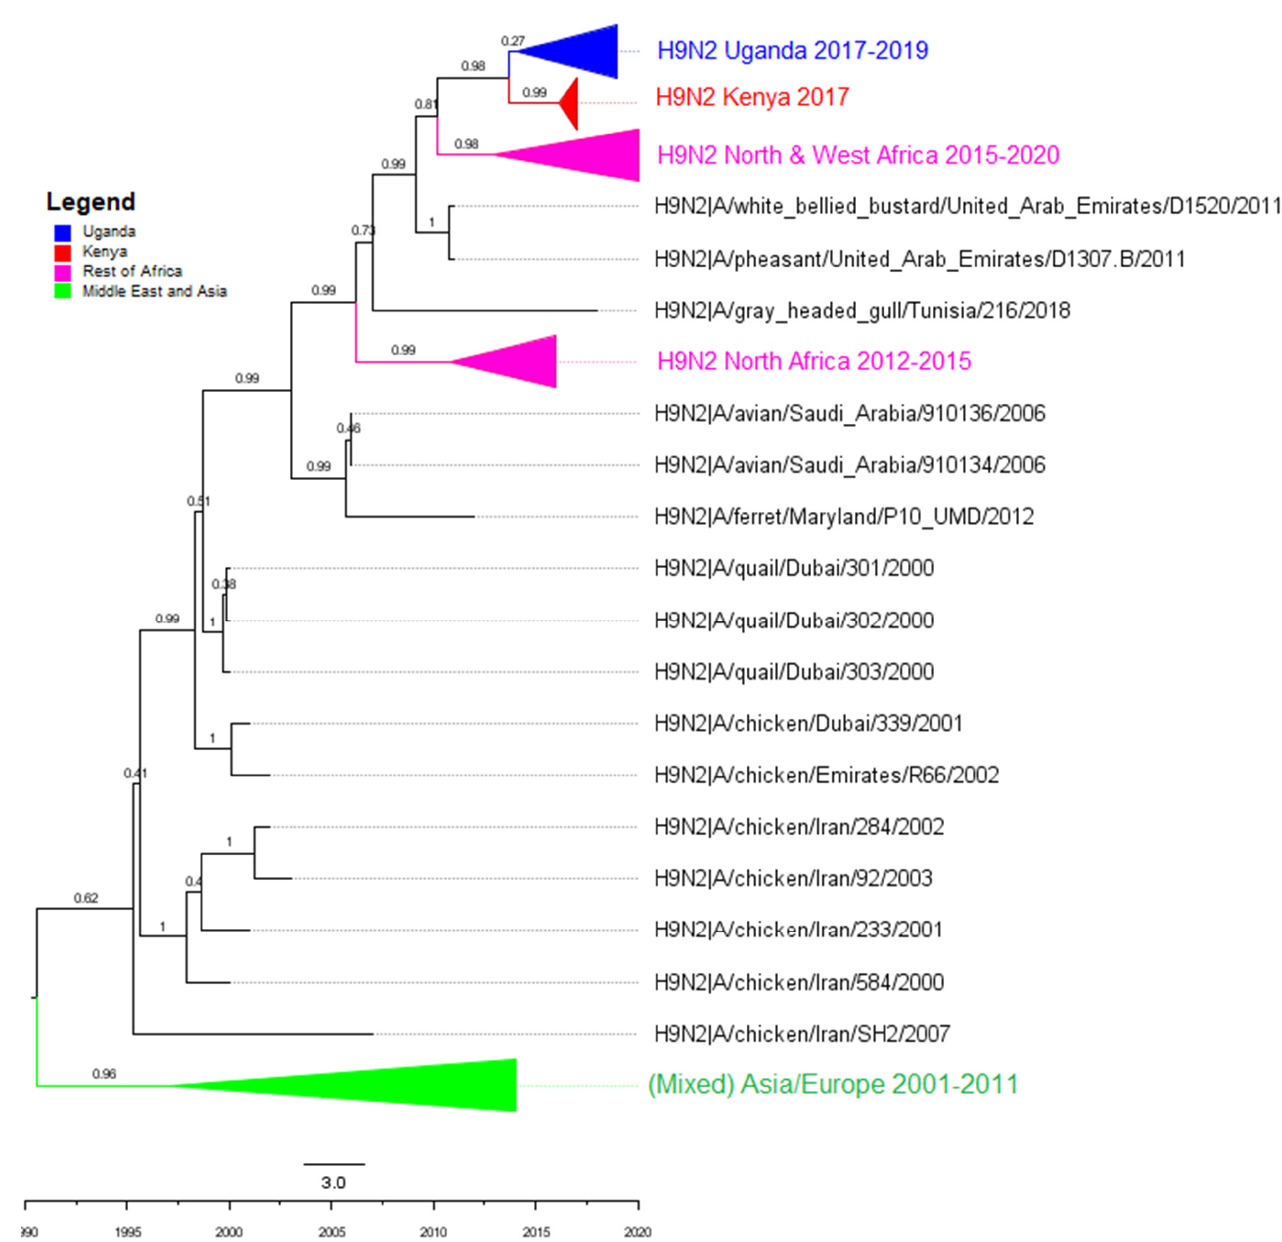
Figure A1. Phylogenetic tree for PB2. Ugandan viruses are highlighted in blue, Kenyan in red, North and West African countries in pink, and the Middle East in the green clade. Posterior probabilities are shown on the branches. tMRCA for Uganda is November 2014. Scales represent substitutions and time..